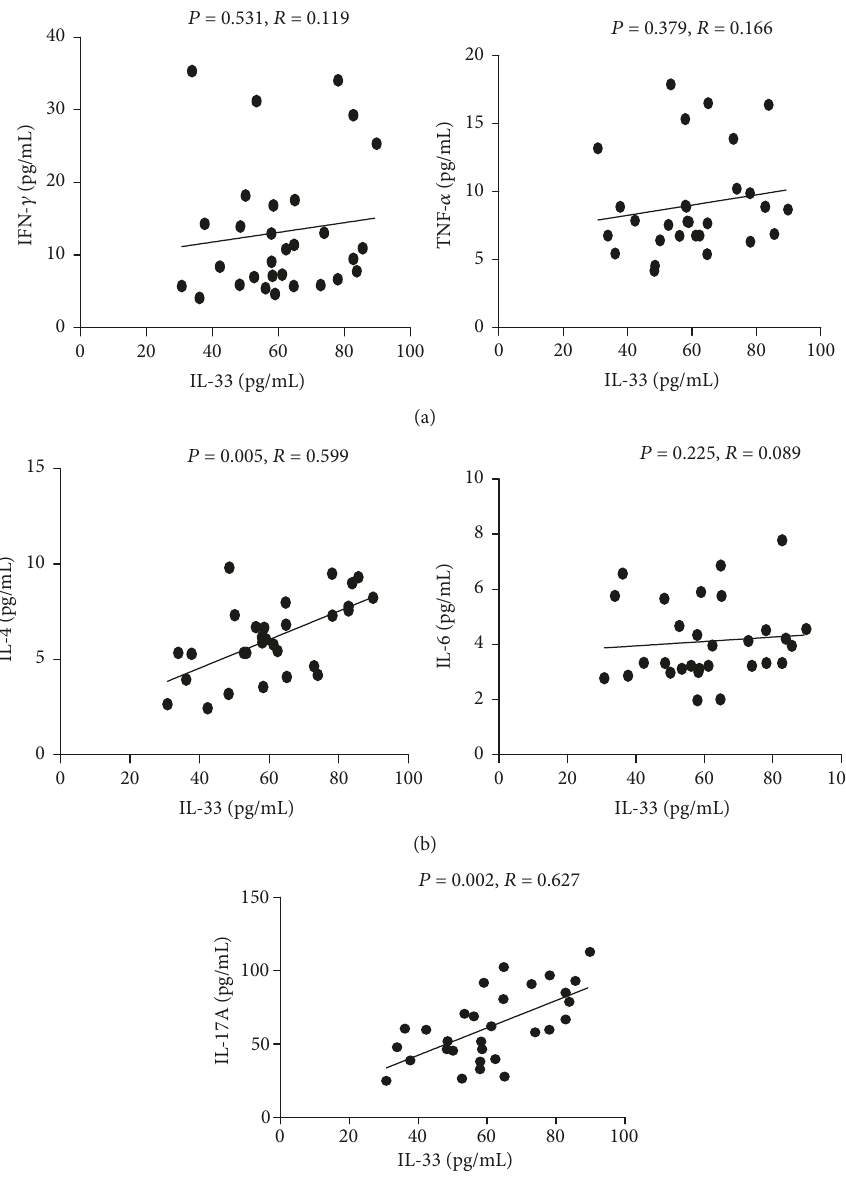
Figure 2: Correlation between IL-33 and other cytokines in AIH patients. (a) Correlation between IL-33 and type 1 cytokine (IFN- γ /TNF- α ) in serum of AIH patients; (b) correlation between IL-33 and type 2 cytokine (IL-4/IL-6) in serum of AIH patients; (c) correlation between IL-33 and type 17 cytokine (IL-17A) in serum of AIH